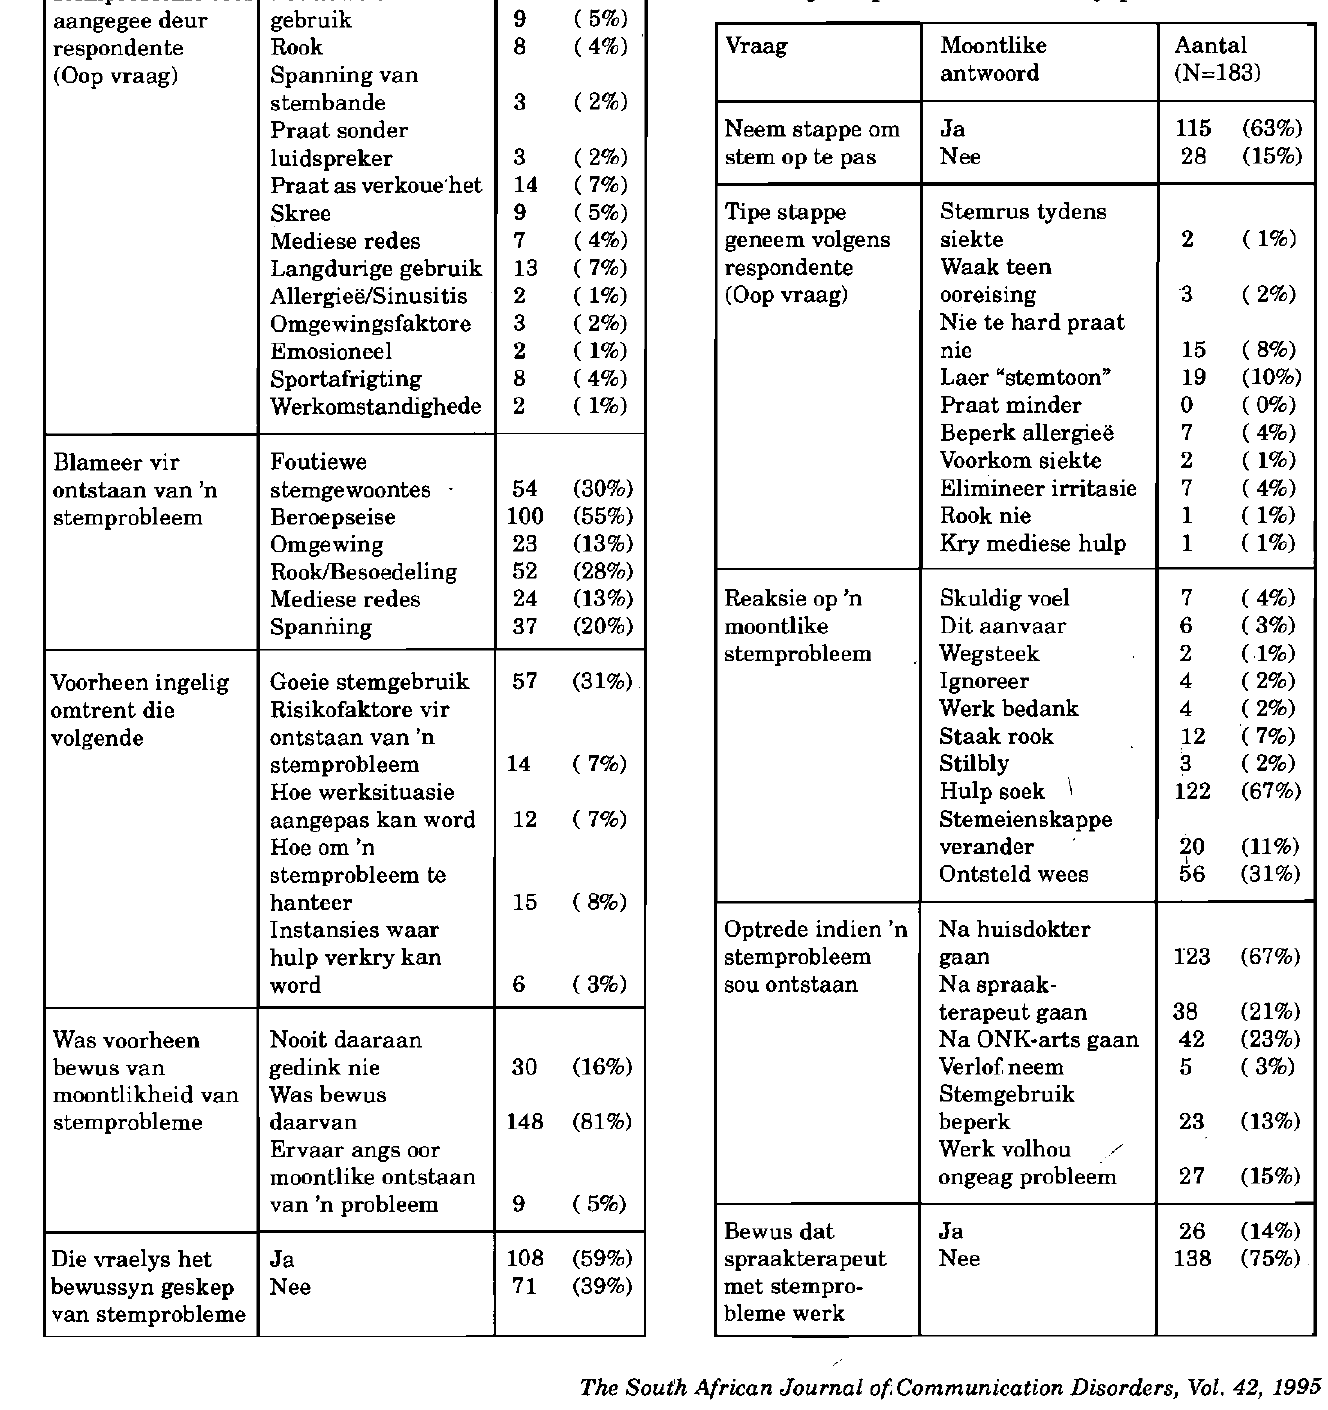
TABEL 3: Optrede en houding teenoor stempro- bleme by die persone in